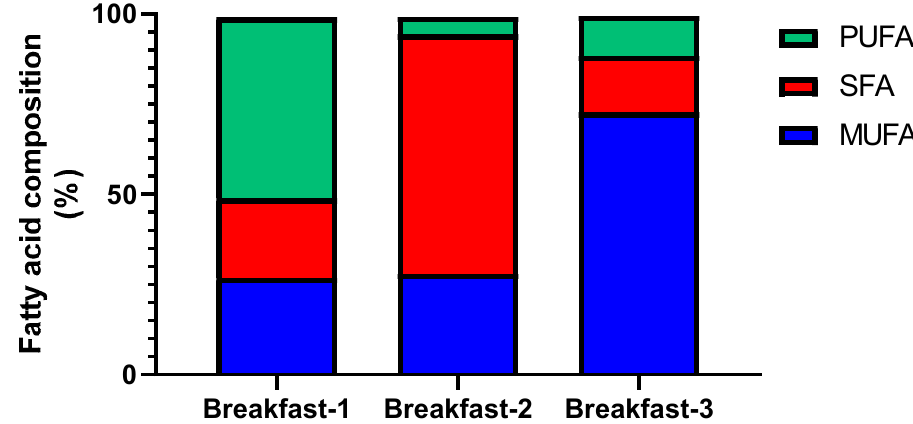
Figure 1. Fatty acid composition (in fat grams per serving) of the different interventions (based on the manufacturer’s information). Breakfast-1 was mainly composed of PUFA, breakfast-2 of SFA, and breakfast-3 of MUFA.